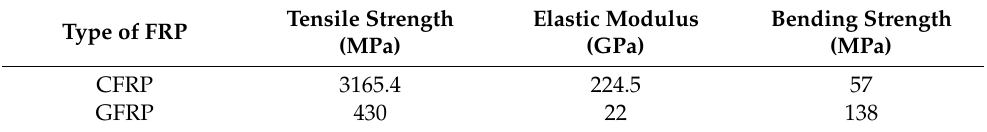
Table 3. Properties of FRP.